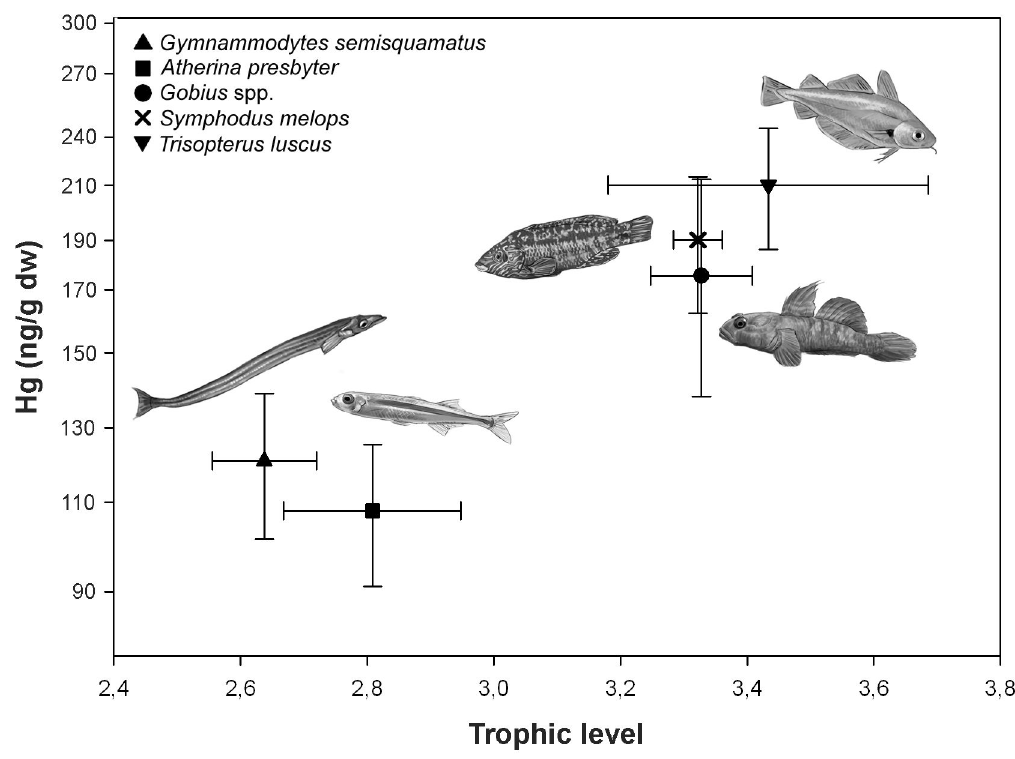
Figure 2. Plot of Hg concentrations (ng/g dry weight in logarithmic scale) and trophic position (mean ± S.D.) in potential prey of European shags sampled in the study area. [27] . Draws are courtesy from Martin Franch